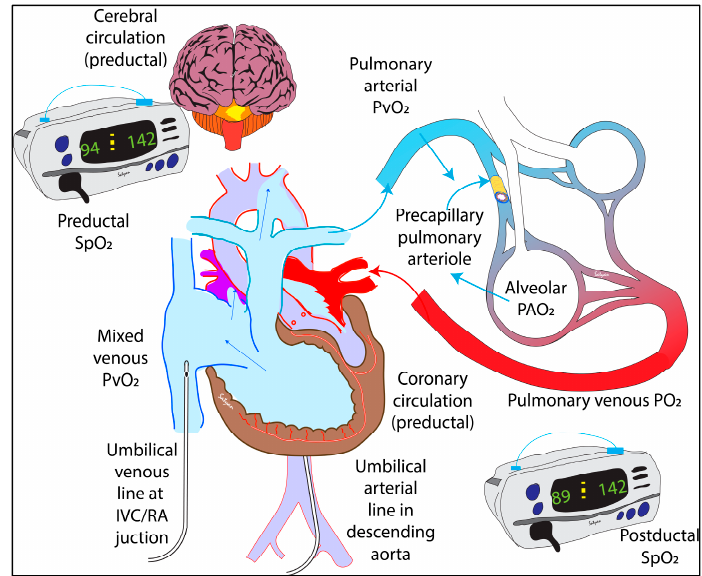
Figure 1. The primary determinant of hypoxic pulmonary vasoconstriction is the precapillary pulmonary arteriole. The oxygen tension at this site is determined by alveolar PAO 2 and pulmonary arterial PO 2 . In the absence of lung disease, pulmonary venous PO 2 and alveolar PAO 2 are usually similar. In the absence of significant shunts, preductal PaO 2 is reflective of pulmonary venous PO 2 . Umbilical venous PO 2 is similar to mixed venous PO 2 and pulmonary arterial PO 2 in the absence of a left-to-right atrial/ductal shunt. Oxygen delivery to the brain and heart is based on preductal PaO 2 and SpO 2 . Postductal PaO 2 (from an umbilical arterial line) can be low and does not predict PVR or oxygen delivery to vital organs. Copyright Satyan Lakshminrusimha. Oxygen supplementation is the most common resuscitative measure for newborns in the delivery room. American Academy of Pediatrics Neonatal Resuscitation Program (AAP NRP) recommends that supplemental O 2 be initiated at concentrations of 21% O 2 in term and 21–30% O 2 in preterm neonates and to titrate based on prespecified preductal saturations [25]. Given the ease and universal use of pulse oximetry, preductal oxygen saturations (SpO 2 ) could be the most efficient way of targeting oxygenation in the delivery room and the neonatal intensive care unit (NICU). However, for a given saturation range, the achieved PO 2 could vary widely and the extremes of SpO 2 have low